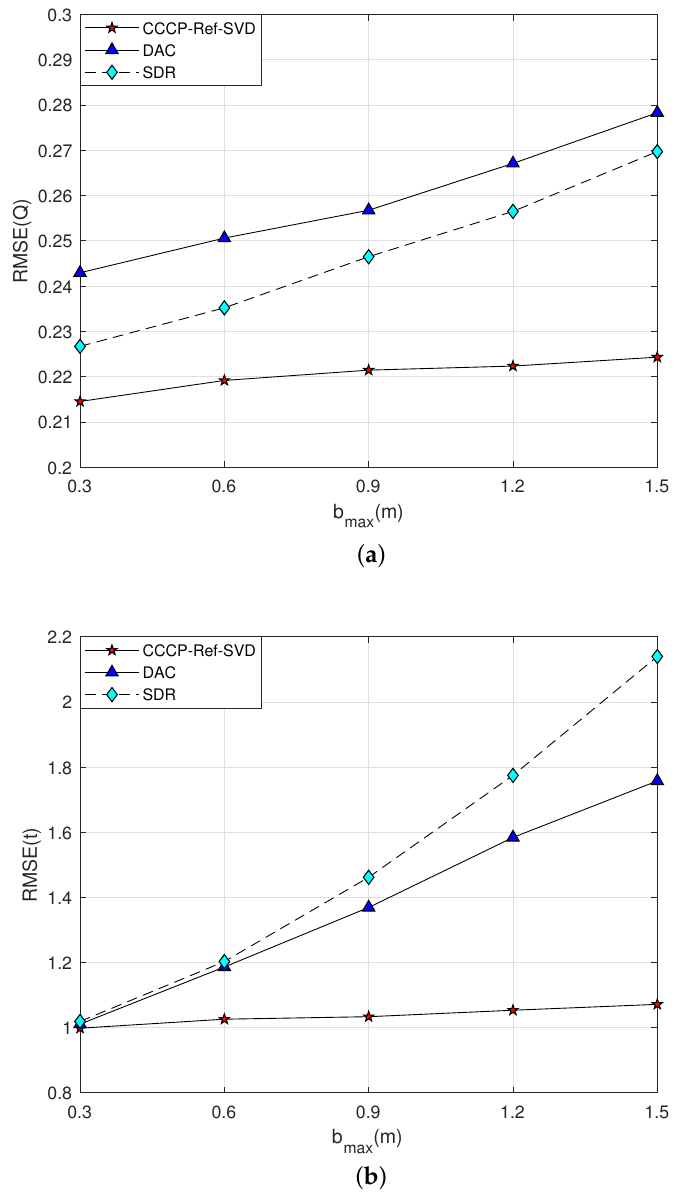
Figure 6. Performance curve of the rigid body’s posture parameter estimation with the maximum value of NLOS error b max increasing in 3–D scenario. ( a ) Q Estimation; ( b ) t